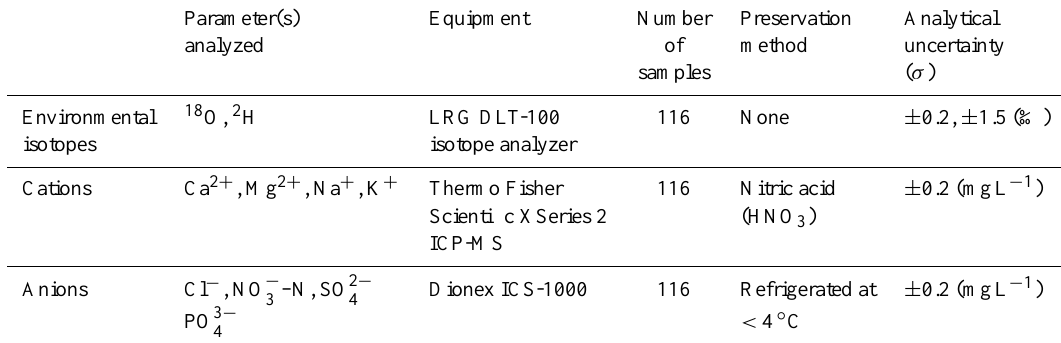
Table 1. UNESCO-IHE laboratory equipment used in chemical analysis of Kaap catchment samples. Parameter(s) Equipment Number analyzed